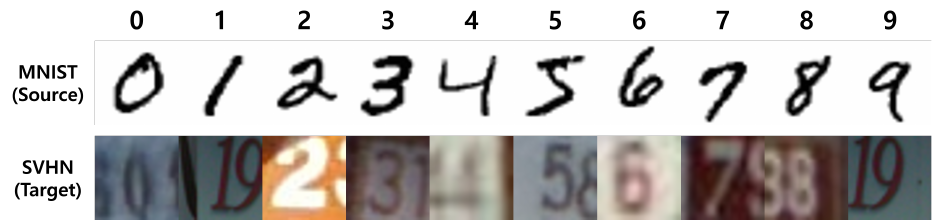
Figure 4. Examples of MNIST and SVHN. The first row shows the MNIST dataset for the source domain. The figures appear synthetic compared to the second-row images in the SVHN dataset acquired from Google Street View. The variations between the two domains are